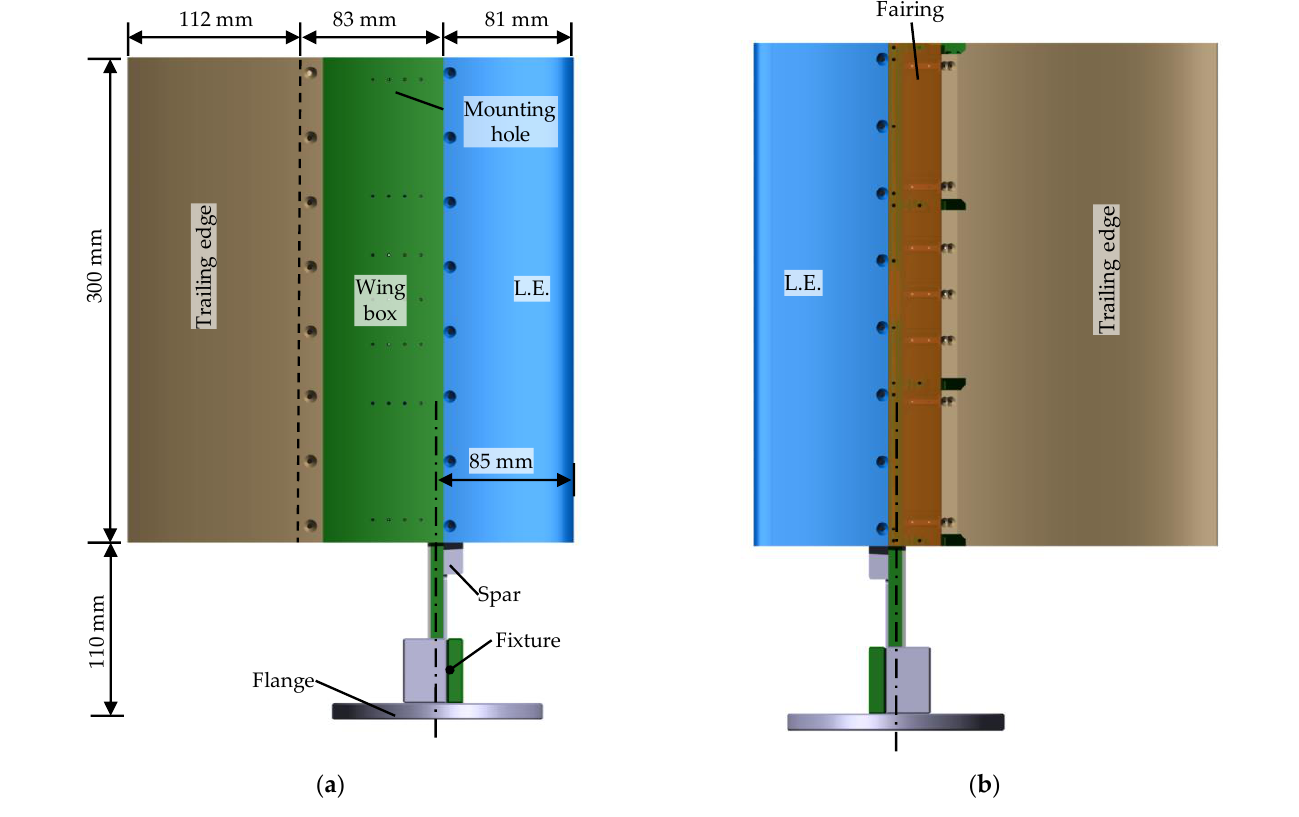
Figure 5. Front and back view of mTE4. ( a ) Upper surface. ( b ) Lower surface. Table 2. Material used for mTE4